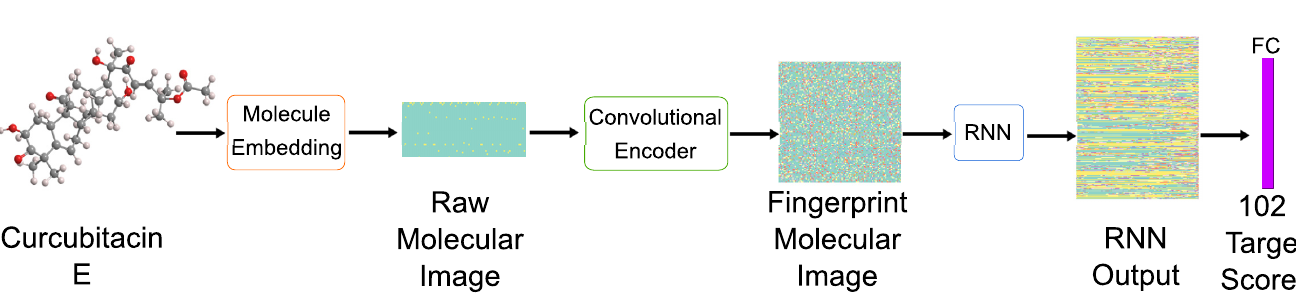
Fig 1. PharmaNet workflow. For each molecule we compute a raw molecular image with nxm dimensions, where n is the number of unique atoms and bonds and m is the molecules’ maximum length. A convolutional encoder produces a fingerprint molecular image that is then analyzed globally by an RNN to predict scores for each of the targets in the AD